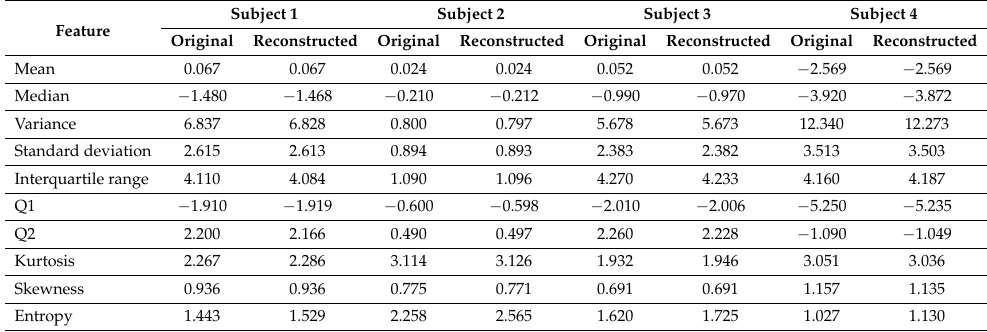
Table 1. Statistical features of the original and reconstructed PPG segments of four